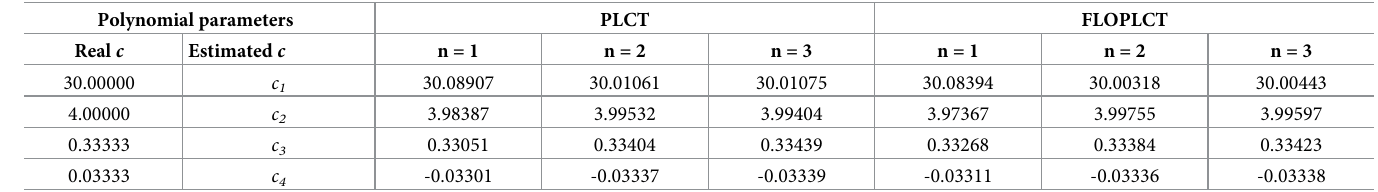
Table 2. The estimated polynomial parameters of the PLCT and FLOPLCT methods in Gaussian noise environment ( SNR = 5 dB ). Polynomial parameters Real